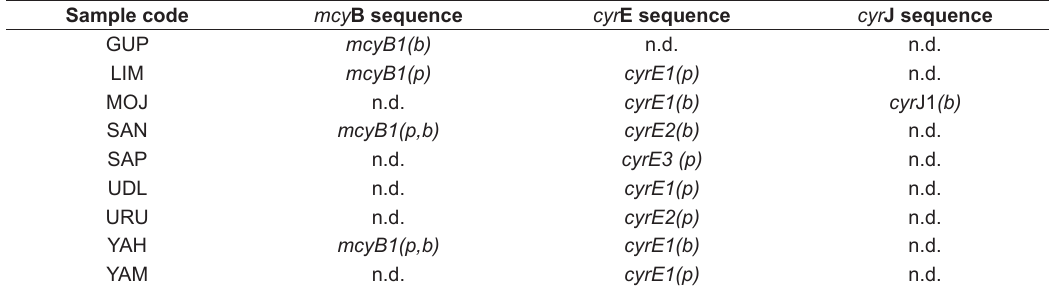
Table 3. List of the sampling points showing the variants of the amplification and sequencing of the assessed genes in this study: mcyB1 from Microcystis panniformis ; cyr E1 from Raphidiopsis raciborskii ; cyrE2 from Aphanizomenon sp; cyrE3 from Raphidiopsis curvata n.d.: not detected. (b)= biofilm samples. Name codes of sampling sites are listed in Table 1 . (p)=plankton